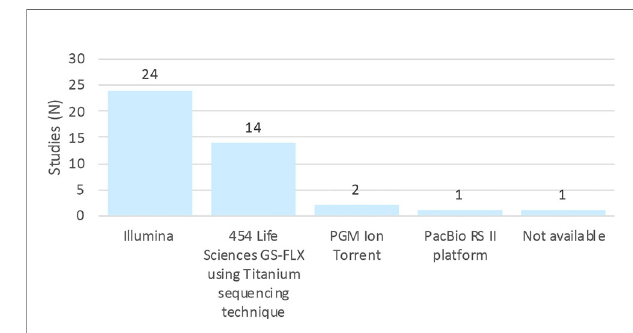
FIGURE 3 | Distribution of studies by platforms of sequencing.